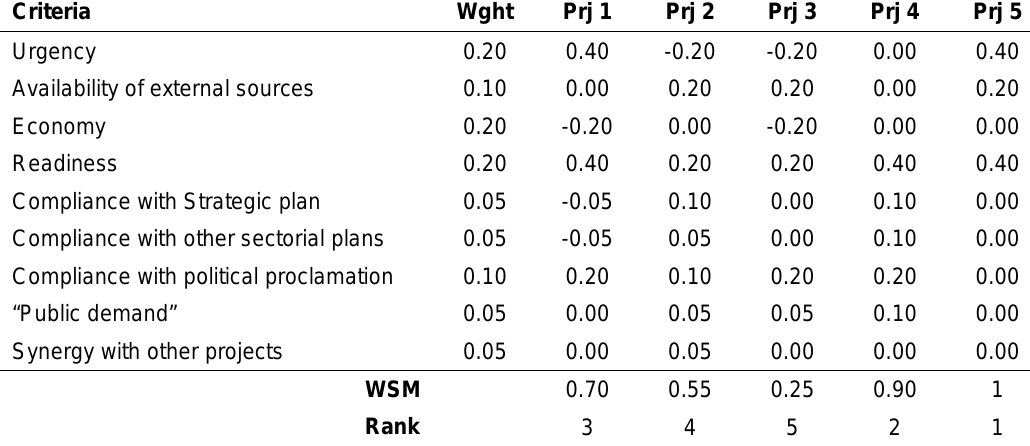
Table 4. Weighted sum method comparison with different weights of criteria.